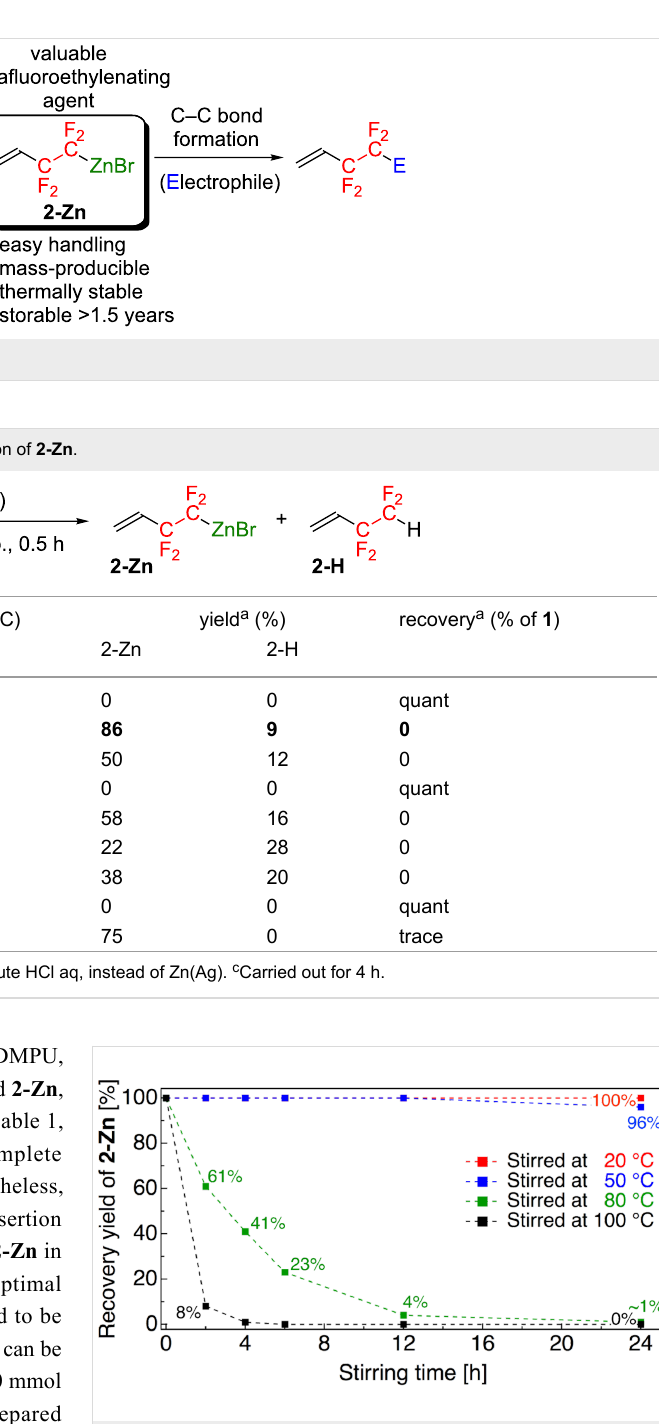
Figure 2: Recovery yield of 2-Zn in DMF (ca. 0.70 M) after stirring at various temperature